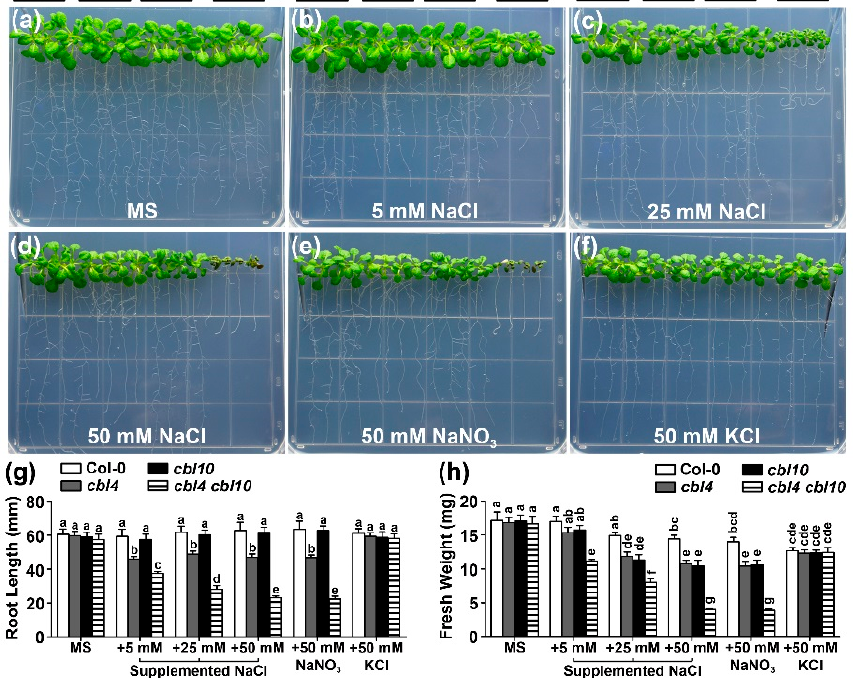
Figure 2. The cbl4 cbl10 double mutant plants are more sensitive to external Na + than cbl4 and cbl10 single mutants. ( a–f ) Growth phenotype of Col-0, cbl4 , cbl10 and cbl4 cbl10 under different concentrations of external NaCl. Five-day-old wild type and mutant seedlings were transferred onto the MS medium or MS supplemented with 5 mM, 25 mM and 50 mM NaCl or 50 mM NaNO 3 or 50 mM KCl. Photographs were taken on the 14th day after the transfer; ( g ) length of primary roots and ( h ) fresh weight of seedlings on the 14th day after the transfer. Data are presented as the mean ± SE of triplicate experiments. Values labeled with different letters are significantly different ( p < 0.05).